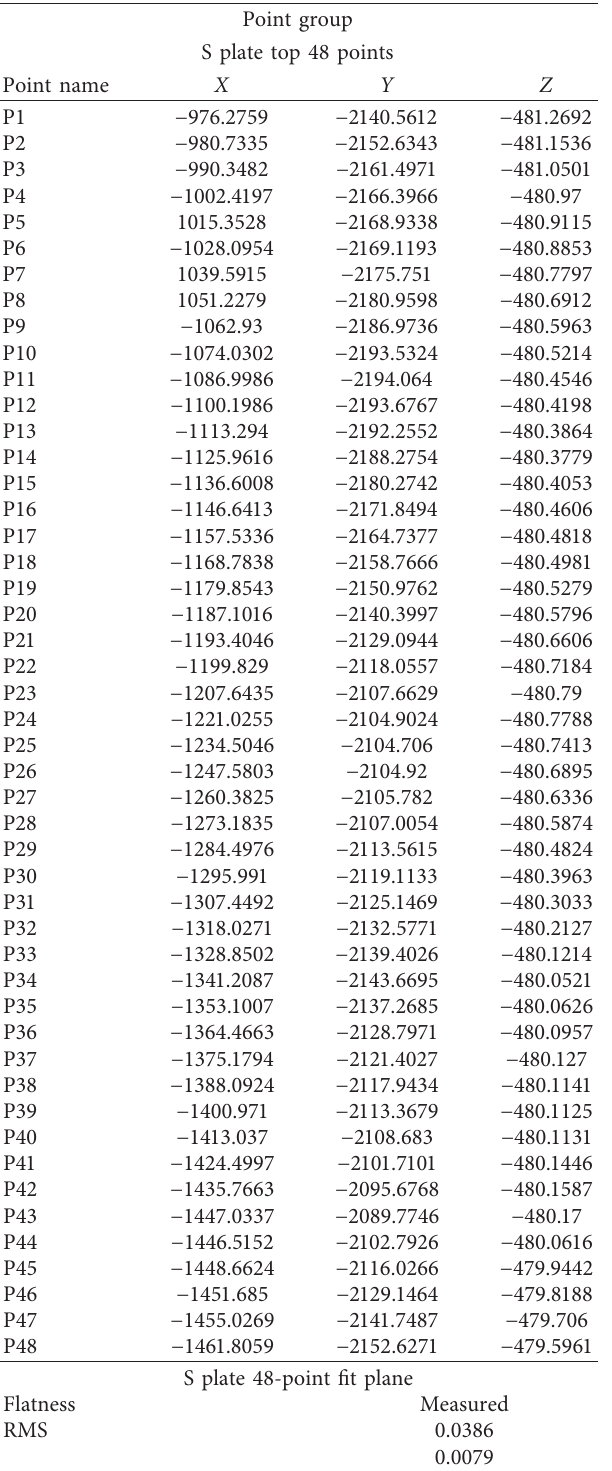
Table 3: Tracker reading taken on top of molding board at different points.